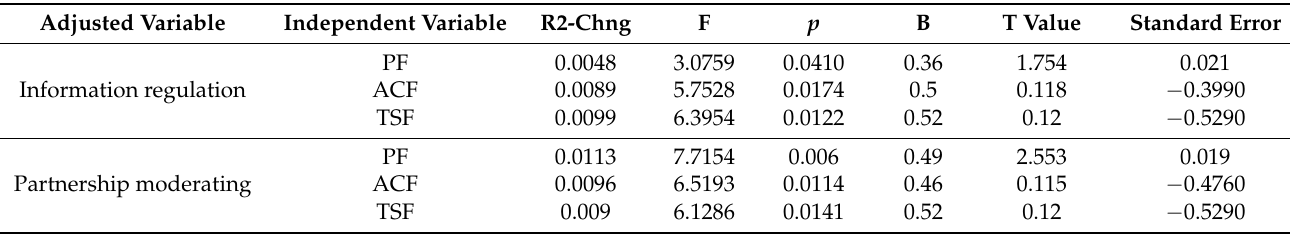
Table 8. Results of the moderating effect